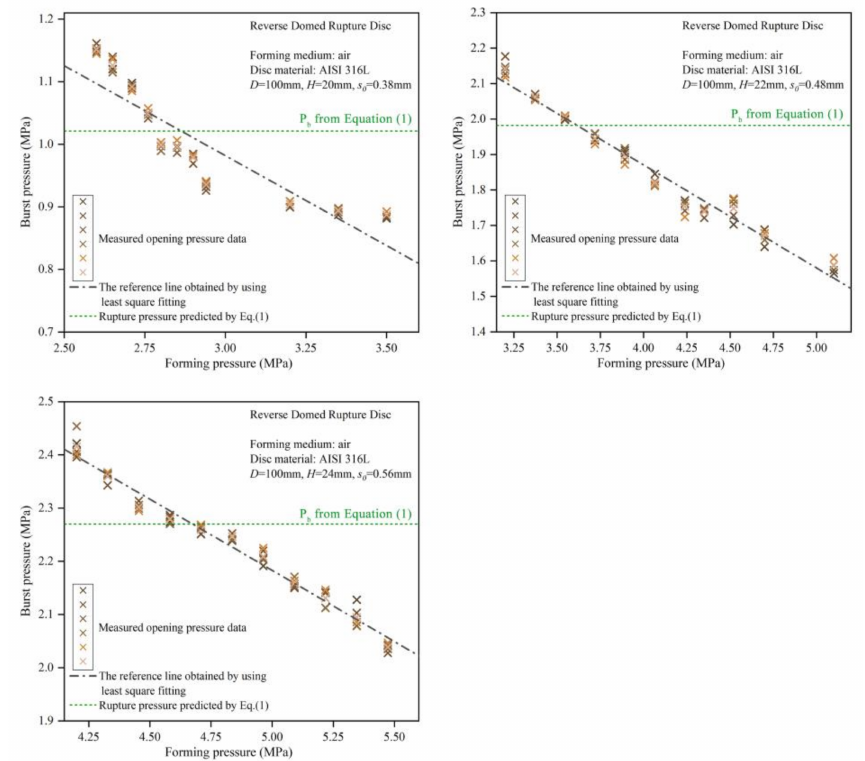
Figure 10. For the pneumatic forming method, the relationship between the burst pressure and the forming pressure of rupture discs with a diameter of 100 mm.